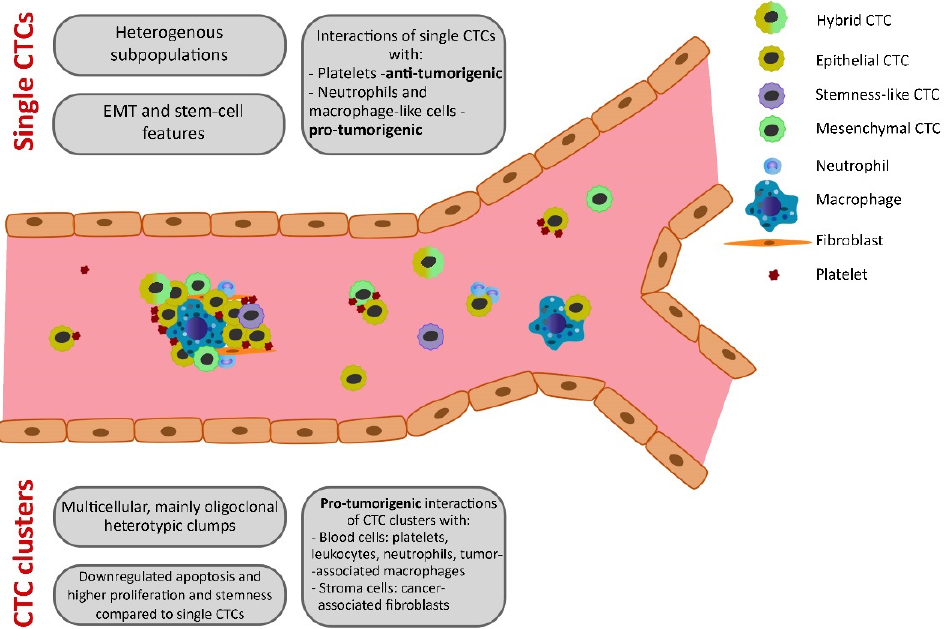
Figure 2. Tumorigenic characteristics and interactions of disseminated breast cancer cells. Presented features of CTC clusters and their pro-tumorigenic interactions with several types of cells indicate higher metastatic potency compared to single CTCs. Abbreviations: CTC, circulating tumor cell; EMT, epithelial-to-mesenchymal transition (designed by Lenka Kalinkova).